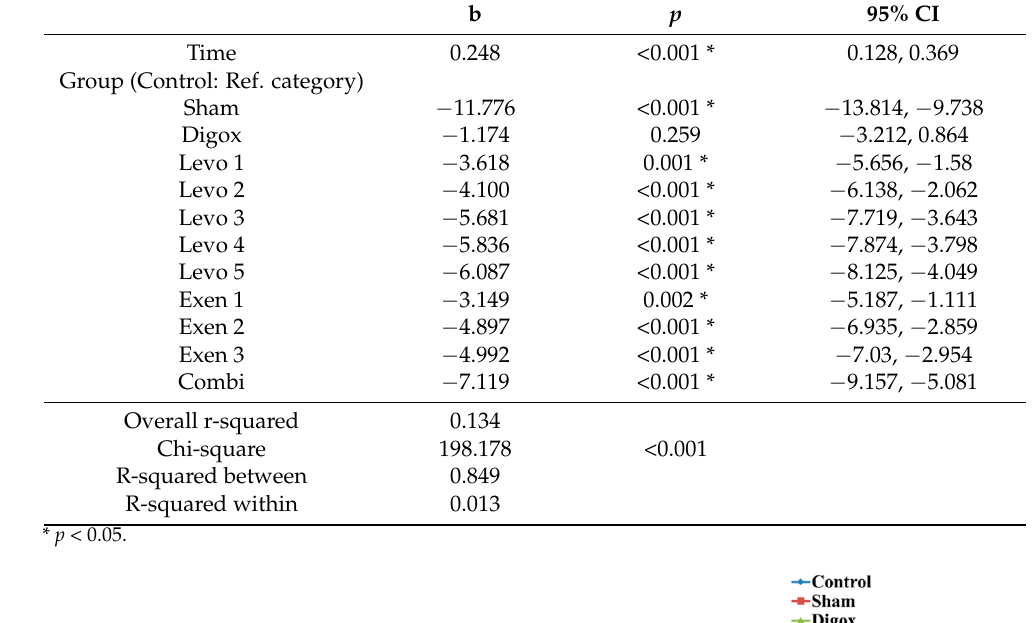
Table 2. Longitudinal analysis for LVEDP for all groups.